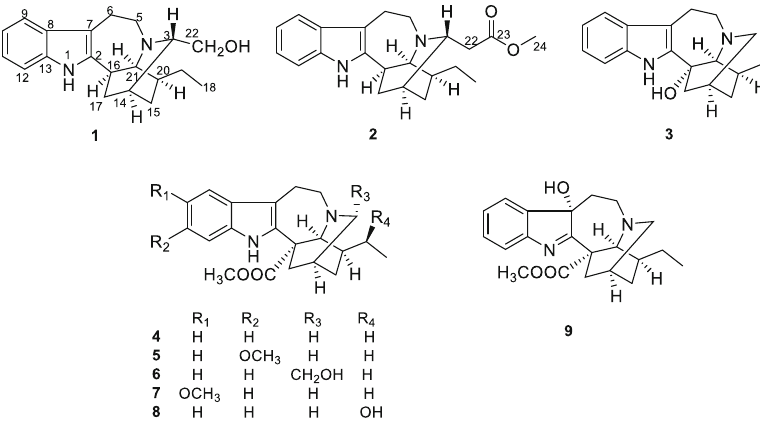
Fig. 1 Structures of compounds 1 –